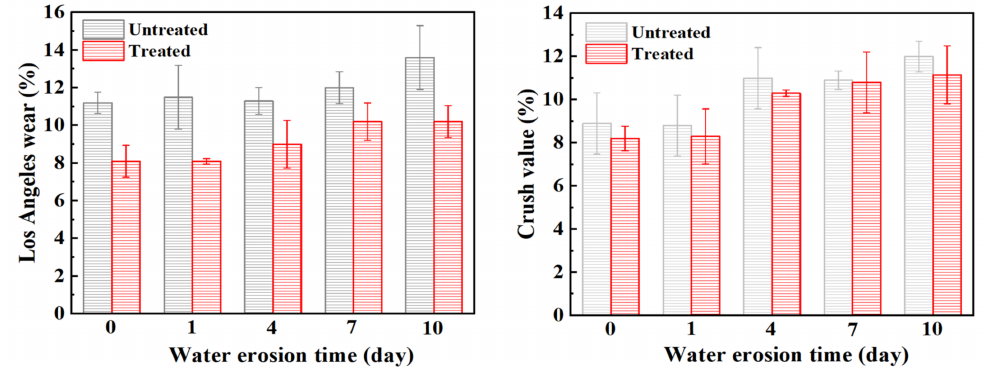
Figure 6. The Los Angeles wear and crush value of steel slag after different water erosion times.